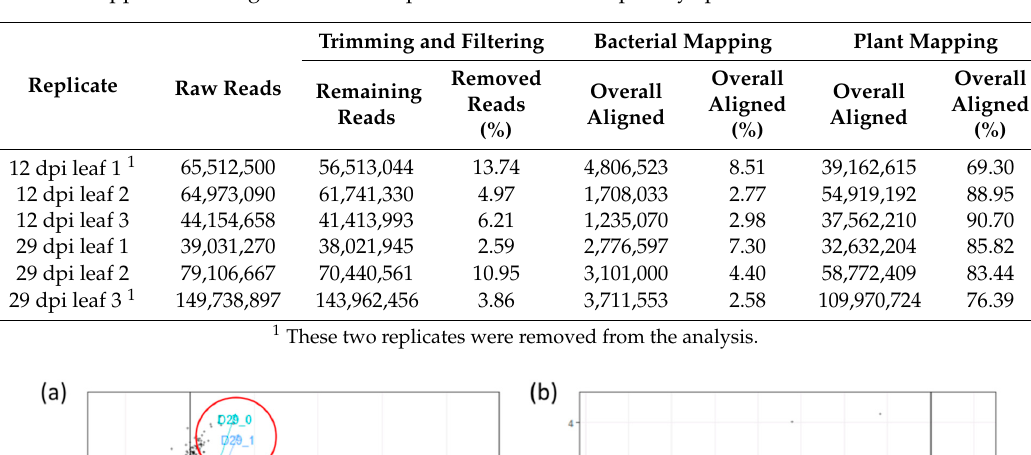
Table 1. Raw reads produced from RNA sequencing per replicate, retained reads resulted from RNA trimming. Reads were mapped on both Xanthomonas fragariae PD 885 T (GenBank assembly accession GCA_900183975.1) and Fragaria vesca (v. 4.0) genomes. Mapping results provided the number and percentage of reads uniquely mapped to the genome and number and percentage of reads mapped more than one time to the respective genome. Finally, the overall aligned amount and percentage of reads mapped on each genome were reported in the table. Dpi: days post inoculation.